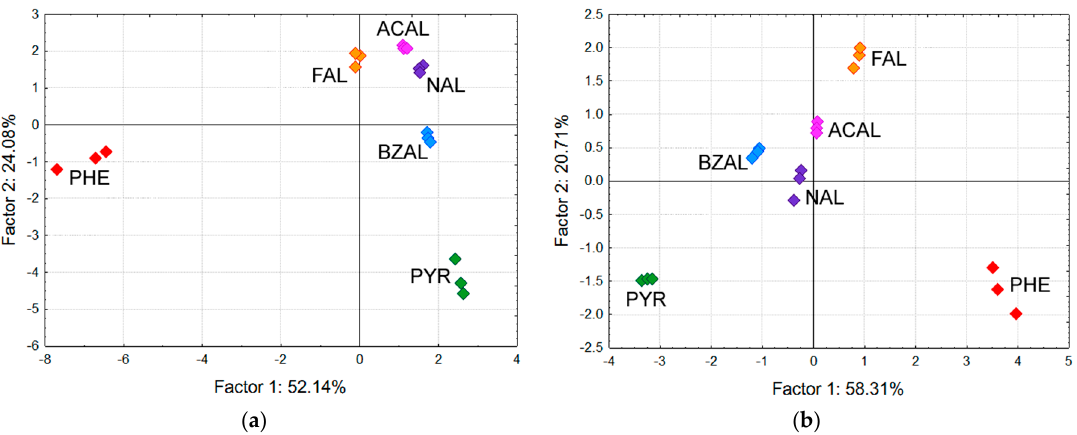
Figure 4. PCA scattering for 6 odorants based on responses of ( a ) all 21 QCM sensors; and ( b ) the 8 top-ranked QCM sensors.